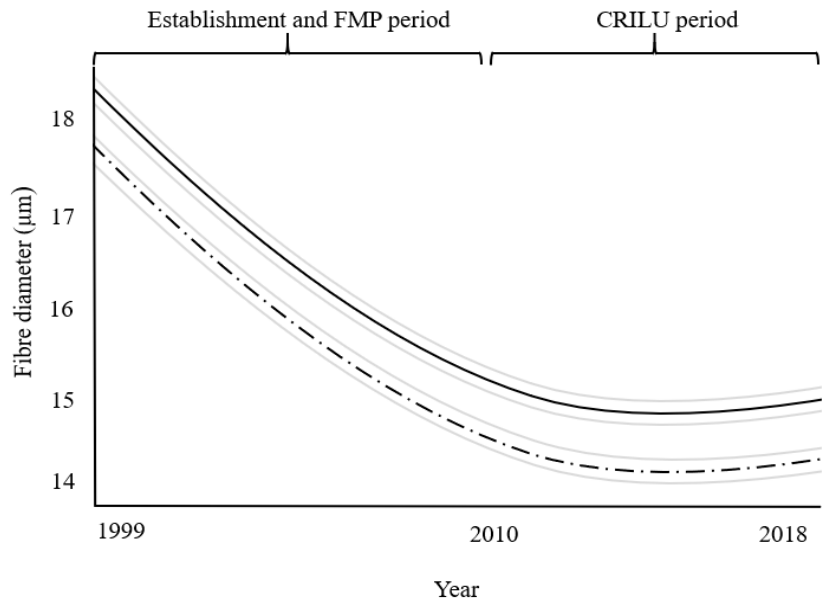
Figure 1. Male (solid line) and female (non-solid line) phenotype trends using a second-degree polynomial regression model for fiber diameter at shearing (298 to 432 days of age) across the entire study period (1999–2018). The light gray lines represent the 95% confidence limits. R 2 for the combined (male and female), male and female models were 0.49, 0.39 and 0.57, respectively. The third-degree polynomial regression model for the combined male and female data explained 61% (R 2 ) of the phenotypic changes in one-year-old lamb GFW. The coefficient of determination (R 2 ) for males and females were 0.55 and 0.54, respectively. Male and female GFW was higher at the end of the study period compared to the establishment phase (1999–2001, Figure